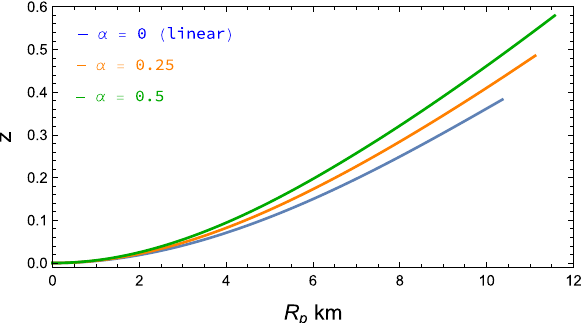
Fig. 9 Surface redshift with respect to proper radius